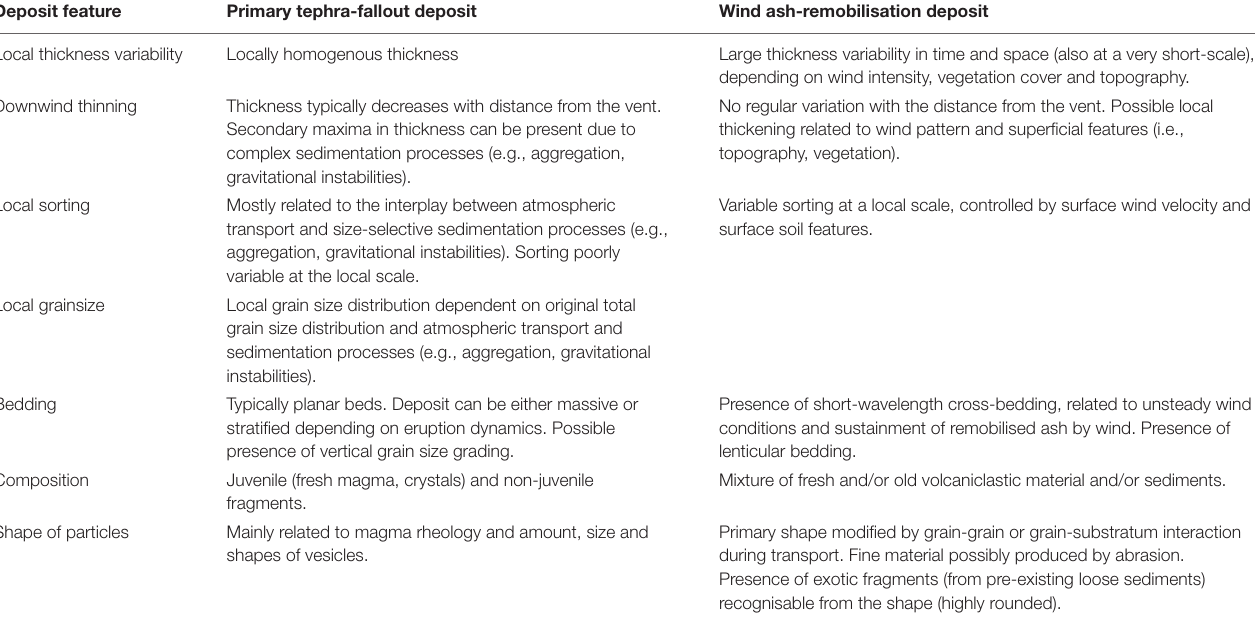
TABLE 2 | Summary of distinctive features of primary tephra-fallout versus wind ash-remobilisation